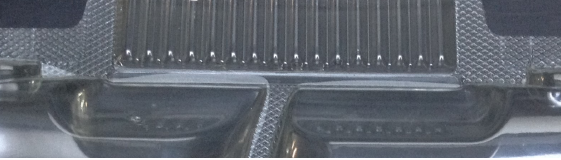
Figure 12 – Weak seal of left chamber and right chamber of the